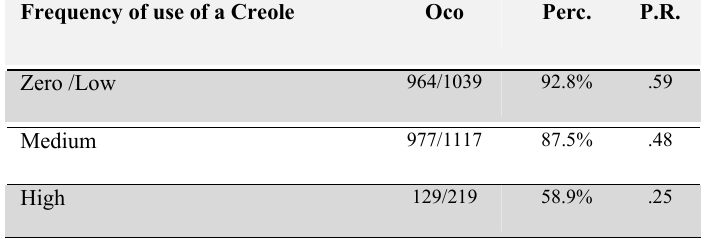
Table XIV. Actuation of frequency of use of a Creole for the application of number mark within the NP – sample ST(2) Frequency of use of a